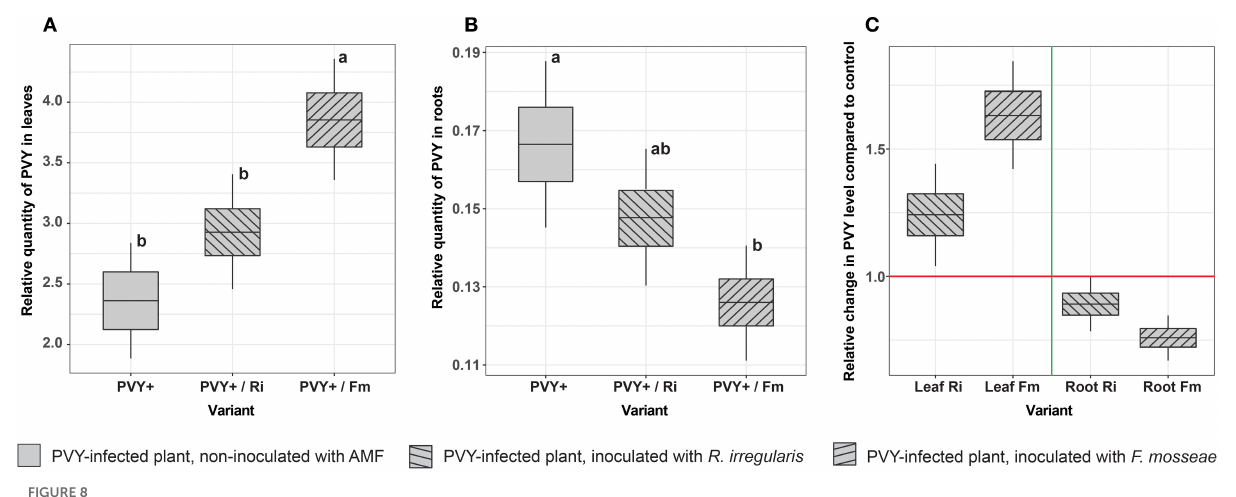
FIGURE8 Effect of AMF on the relative quantity of PVY in leaves (A) and roots (B) in virus-infected potatoes. Each value is calculated as a ratio of the PVY level in mycorrhizal plants to that in nonmycorrhizal (control) plants. (C) Shows the fold change in the PVY level between mycorrhizal and nonmycorrhizal plant roots. The statistically significant differences are marked with letters. The same letters indicate no significant differences ( p >